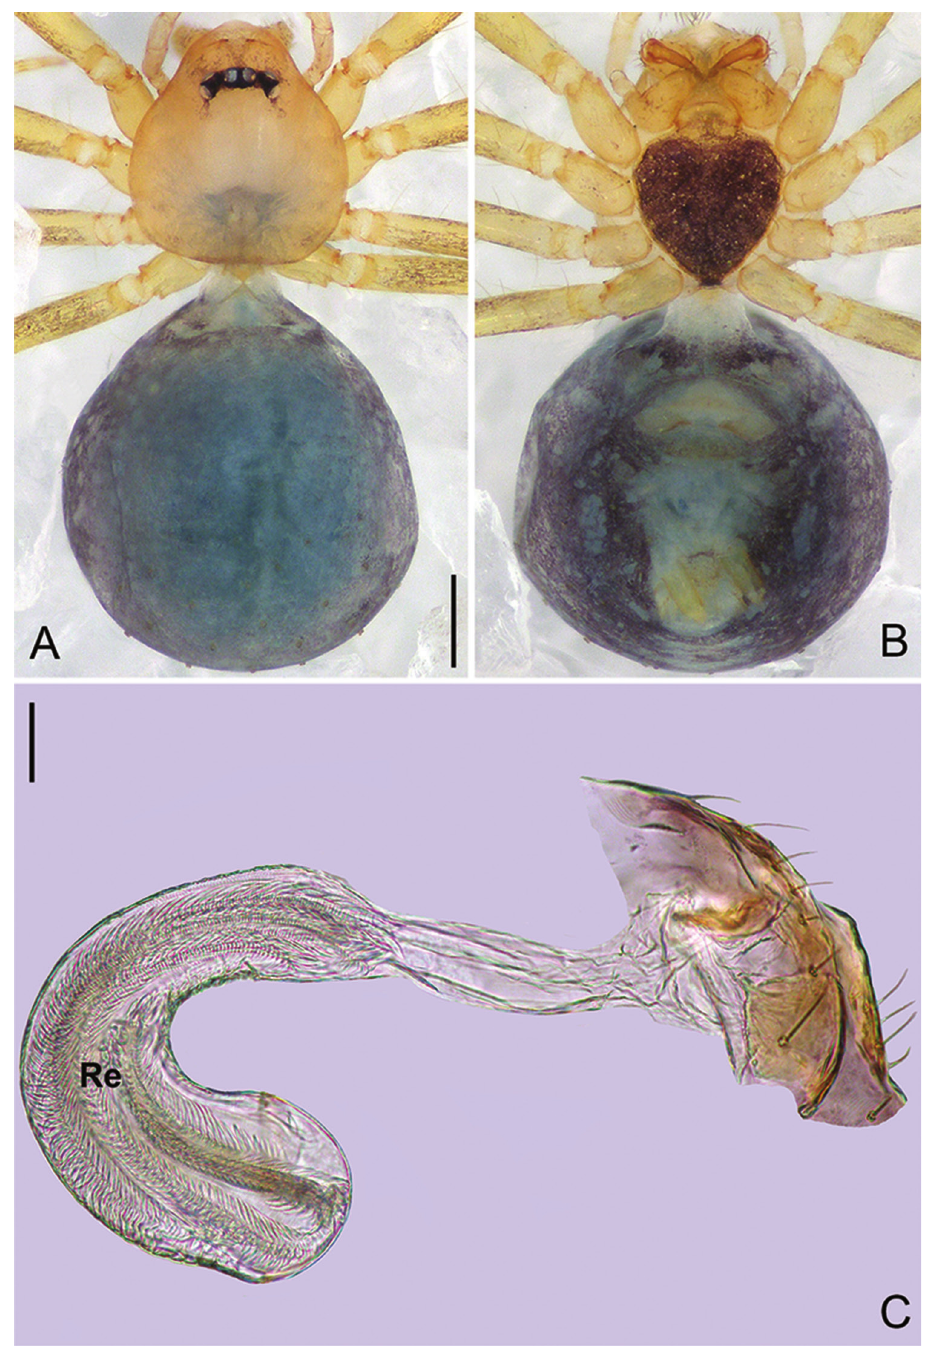
Figure 14. Pinelema lizhuang Zhao & Li, sp. n., female paratype. A Habitus, dorsal view B Habitus, ventral view C Endogyne, lateral view. Scale bars: 0.2 mm ( A–B ), 0.05 mm ( C